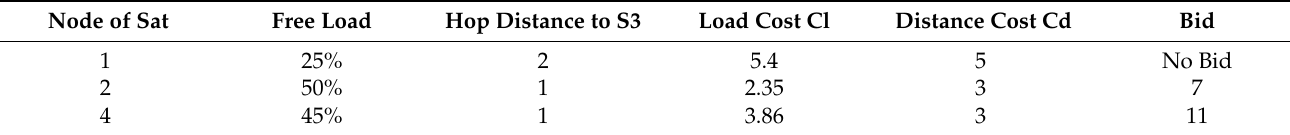
Table 1. Individual cost and fused bid values for all candidate nodes of the satellites.